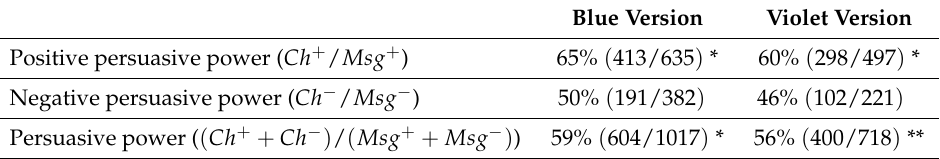
Table 4. The measure of the persuasive power of the violet and blue versions of the messages. Ch + / Msg + is the fraction of times that the users chose a menu after a positive message. Ch − / Msg − is the fraction of times that the users did not choose a menu after a negative message. ( Ch + + Ch − ) / ( Msg + + Msg − ) is the micro-average between positive and negative persuasive power. * denotes significance at p ≤ 0.001 in the chi-squared tests; ** denotes significance at p ≤